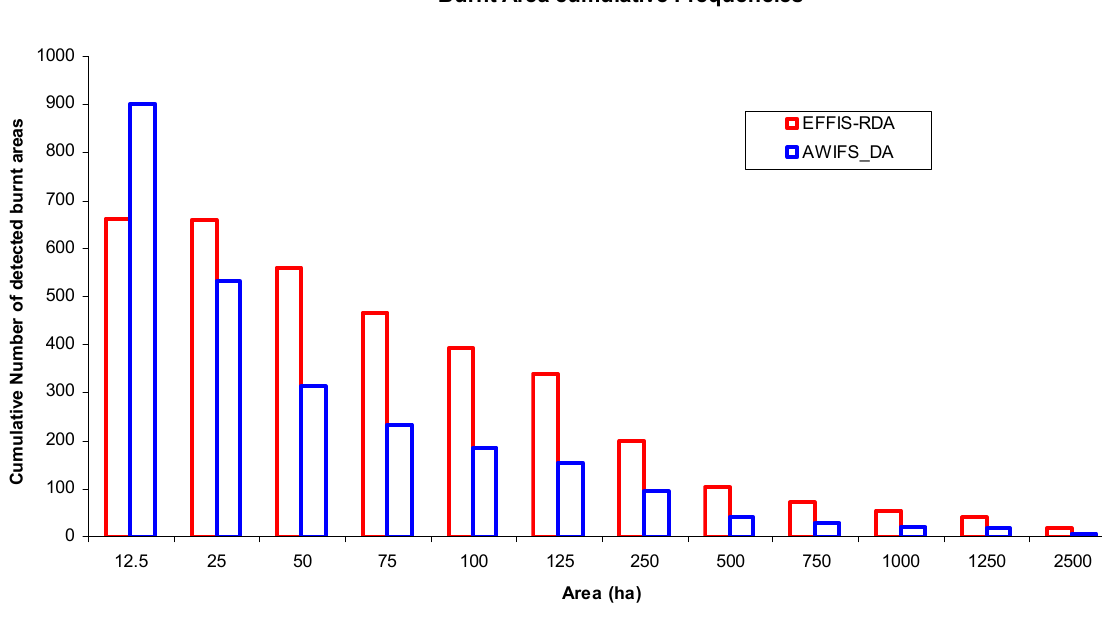
Figure 4. Burned area cumulative frequencies for MODIS-based EFFIS Rapid Damage Assessment (EFFIS-RDA) and IRS-AWiFS-based burned scar map. Burnt Area cumulative Frequencies